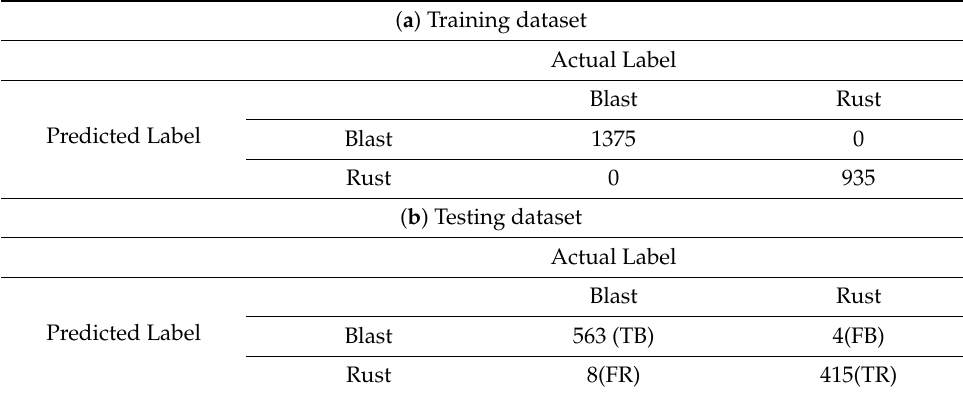
Table 5. Confusion matrix of non-pre-trained ‘Custom-Net’ model.